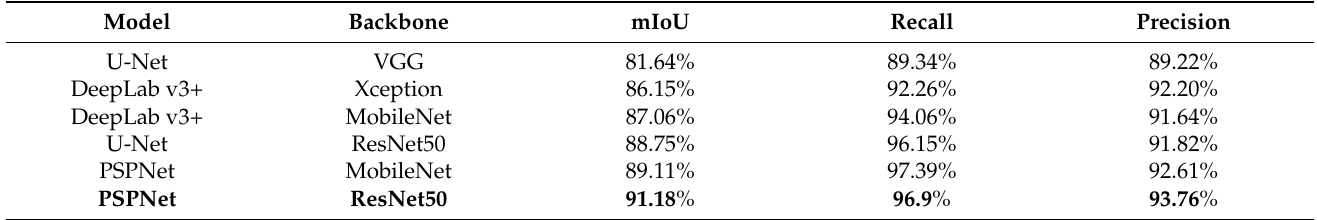
Table 5. The results of the suggested model. Numbers in bold represent the best model for identifying landslides (with mIoU metric as the final